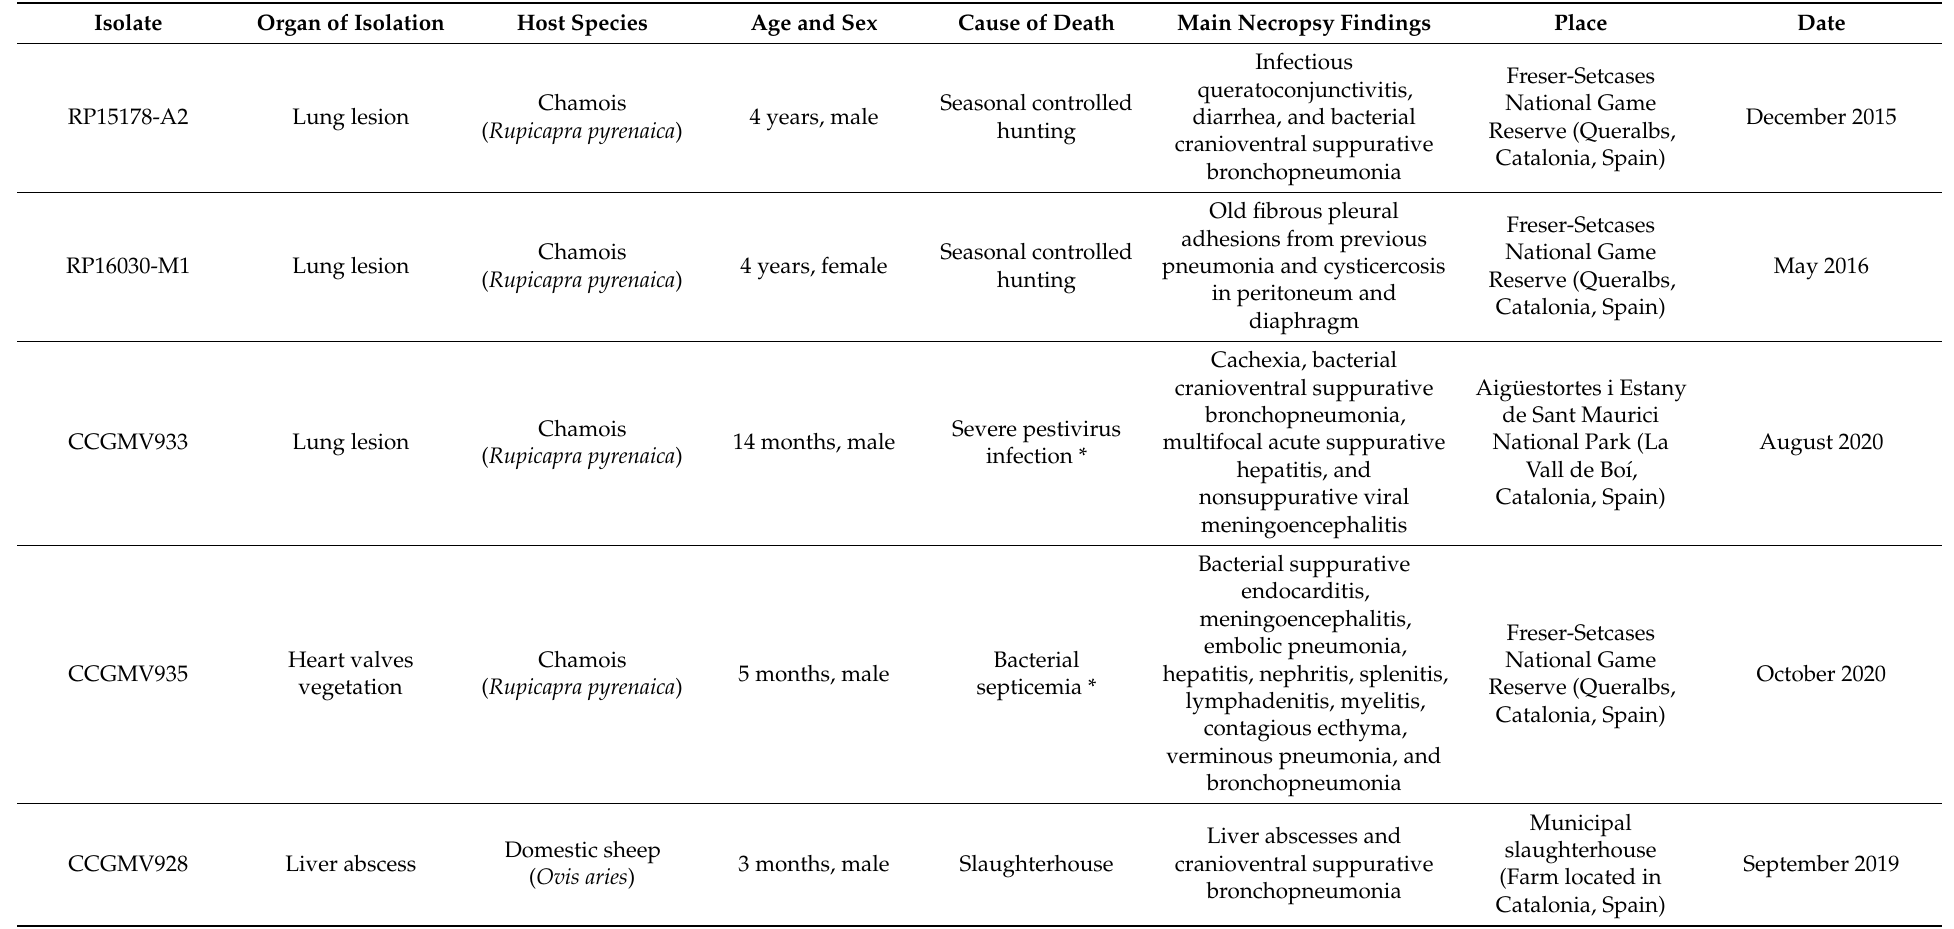
Table 1. Main characteristics of the Streptococcus ruminantium isolates included in this